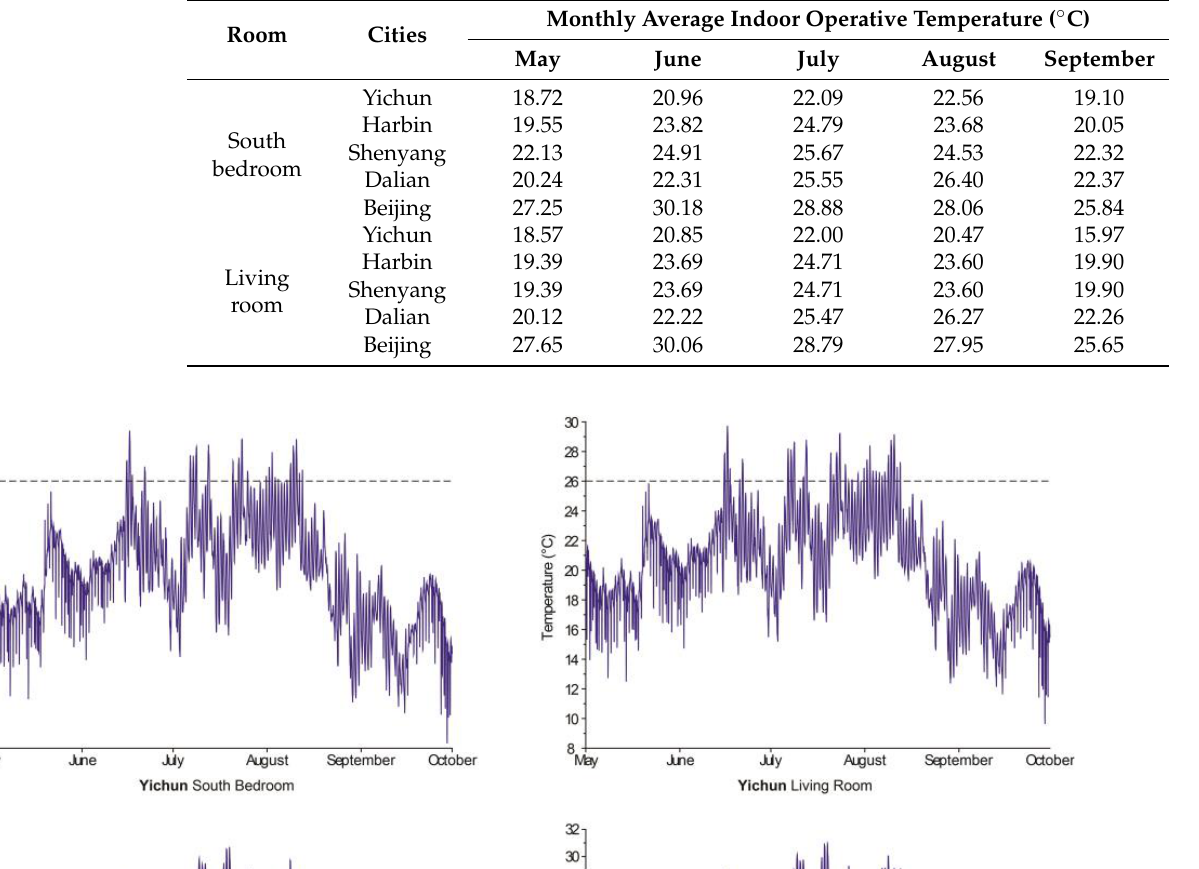
Table 12. Average monthly indoor operative temperature from May to September.